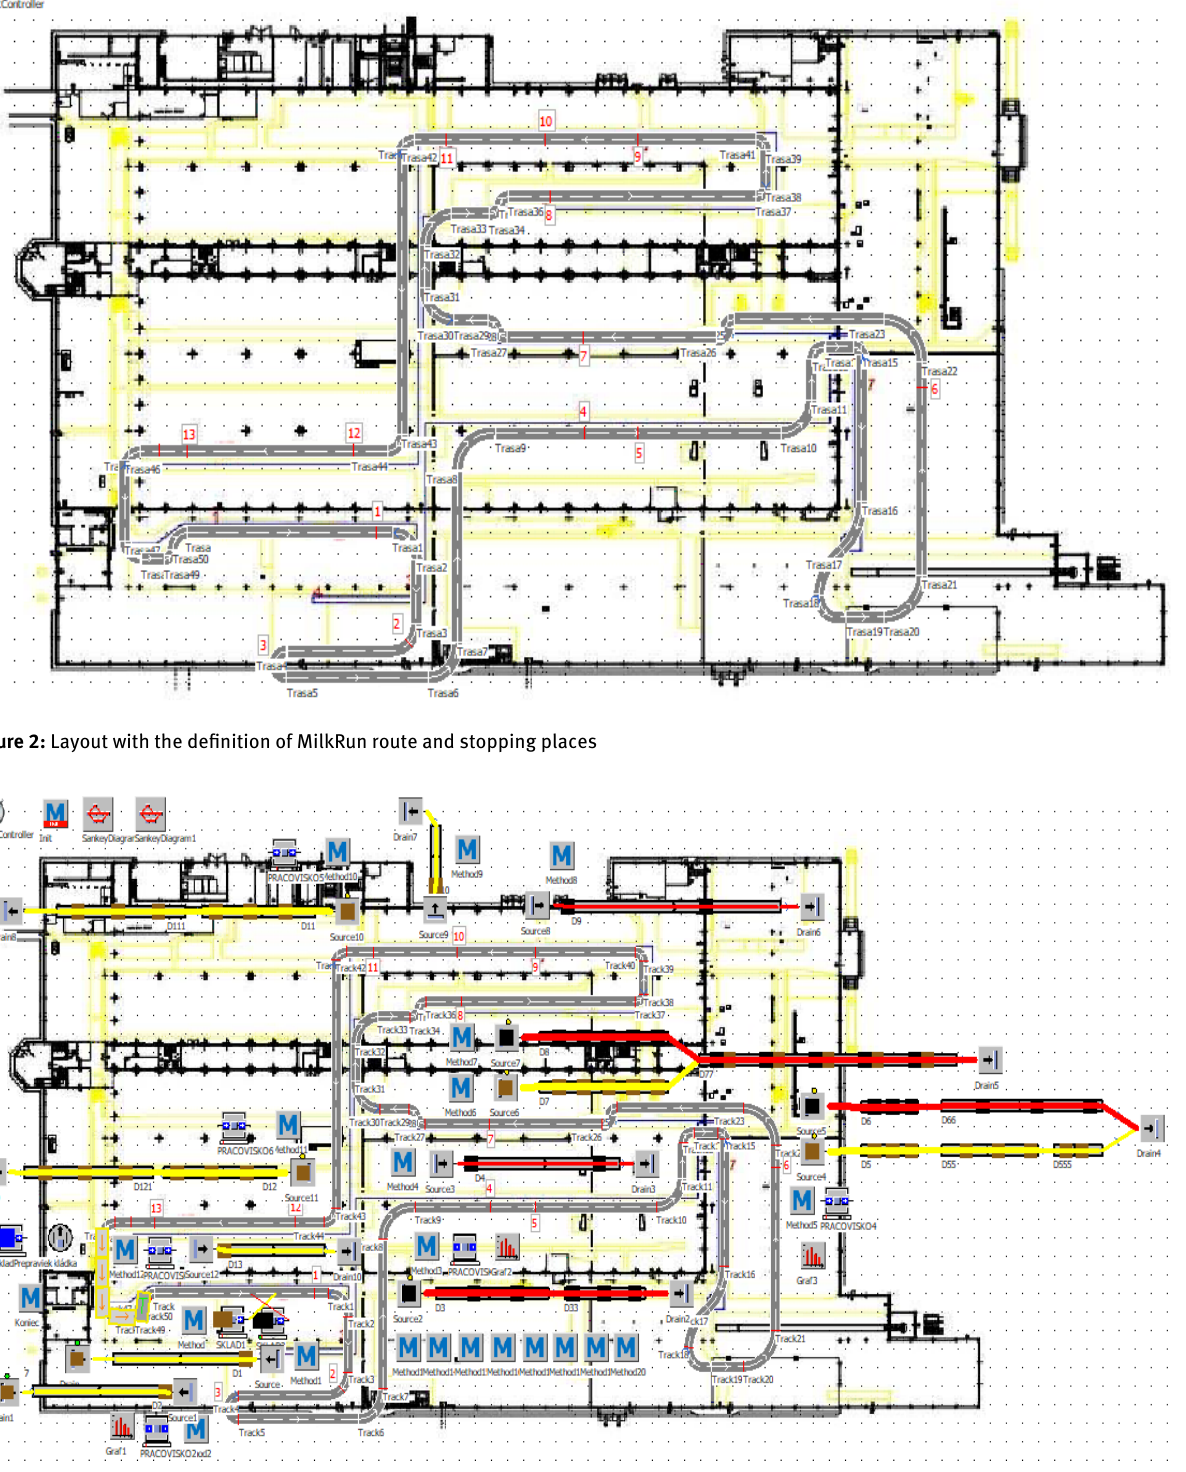
Figure 3: Demonstration of material flow for metal extrusions 1 and also metal extractions